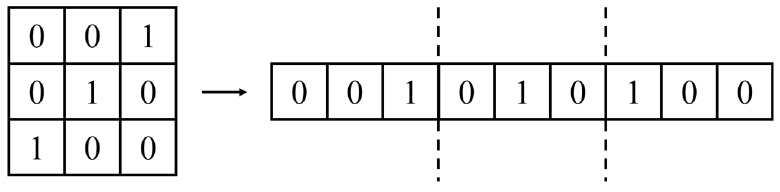
Figure 4. Process of the coding technique .